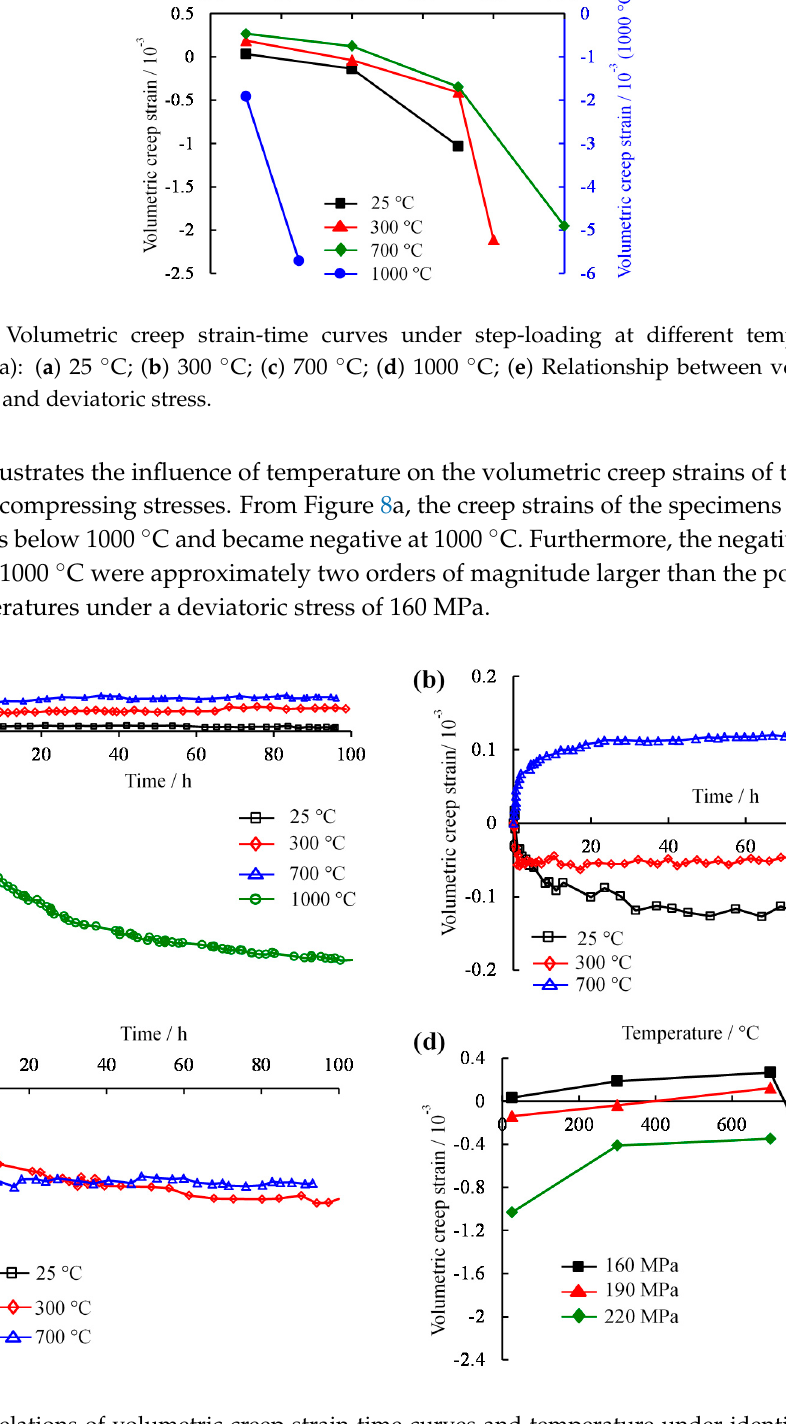
Figure 8. Relations of volumetric creep strain-time curves and temperature under identical stress condition ( σ 3 = 25 MPa): ( a ) σ 1 − σ 3 = 160 MPa; ( b ) σ 1 − σ 3 = 190 MPa; ( c ) σ 1 − σ 3 = 220 MPa; ( d ) Relationship between volumetric creep strain and temperature.